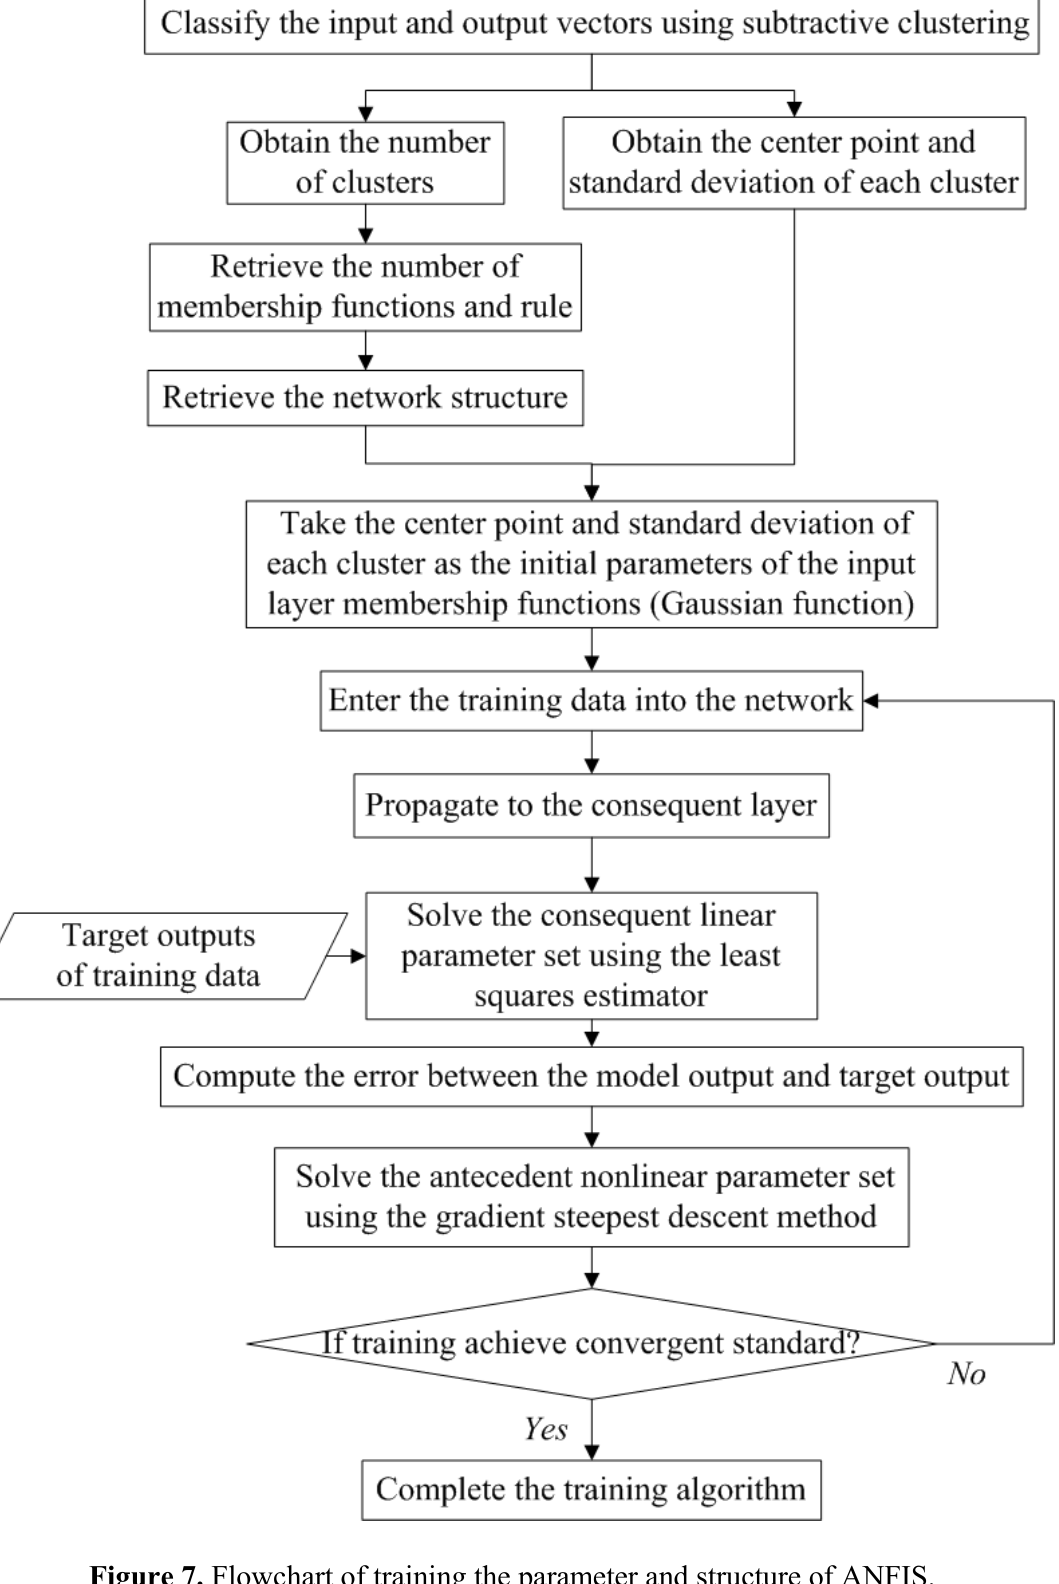
Figure 7. Flowchart of training the parameter and structure of